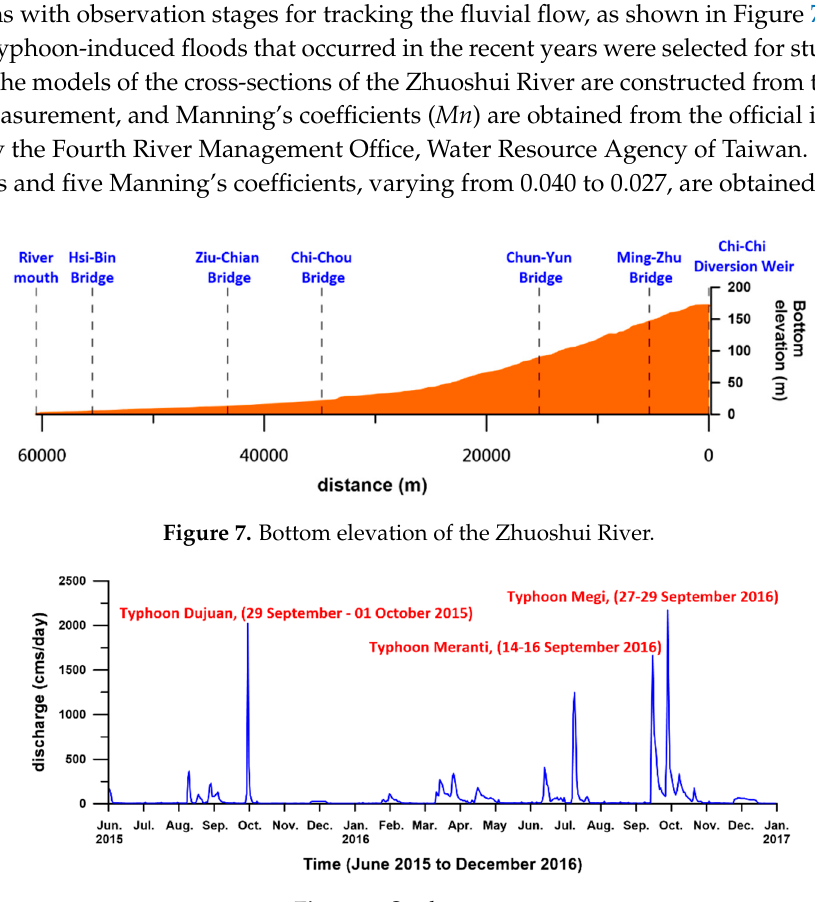
Figure 8. Study Figure 8. Study events. Figure 8. Study events.